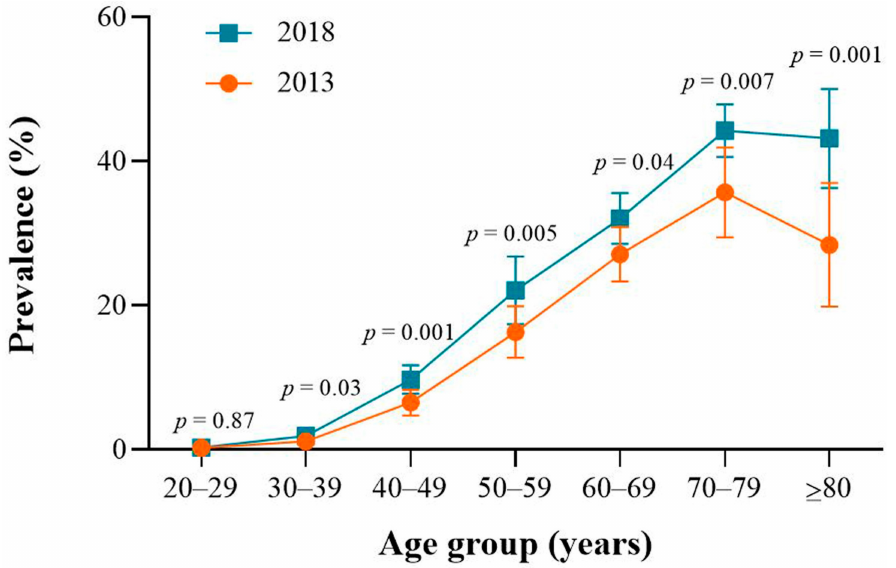
Figure 3. Age-specific 6-month prevalence rates of circulatory system diseases (CSDs) between 2013 and 2018 in Hunan Province, China.